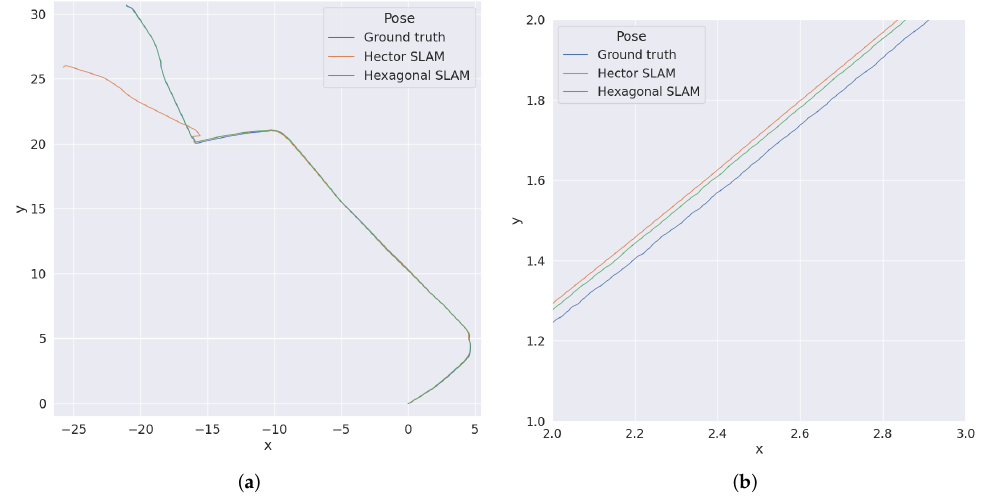
Figure 10. Ground truth position and position estimations for MIT Data Set—recording from 27 January 2012. ( a ) The whole test run. ( b ) Close